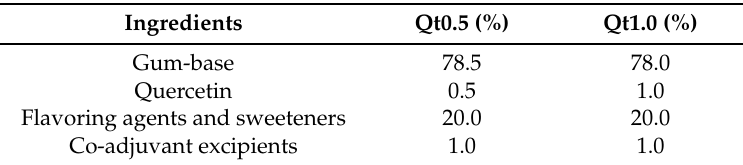
Table 2. Composition (%) of 1.0 g of chewing